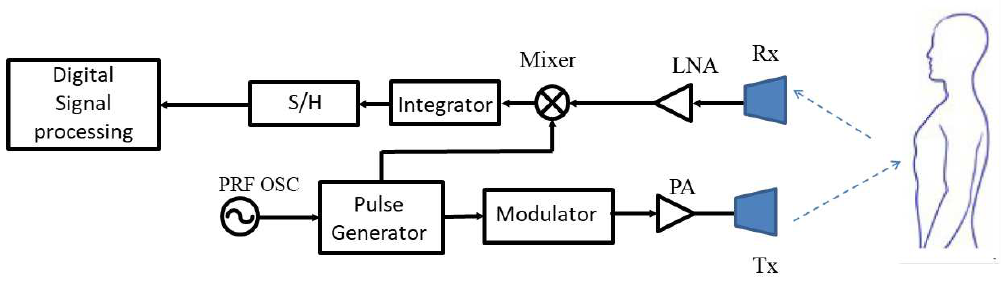
Figure 18. Block diagram of a typical UWB radar system. PRF, pulse repeat frequency; OSC,